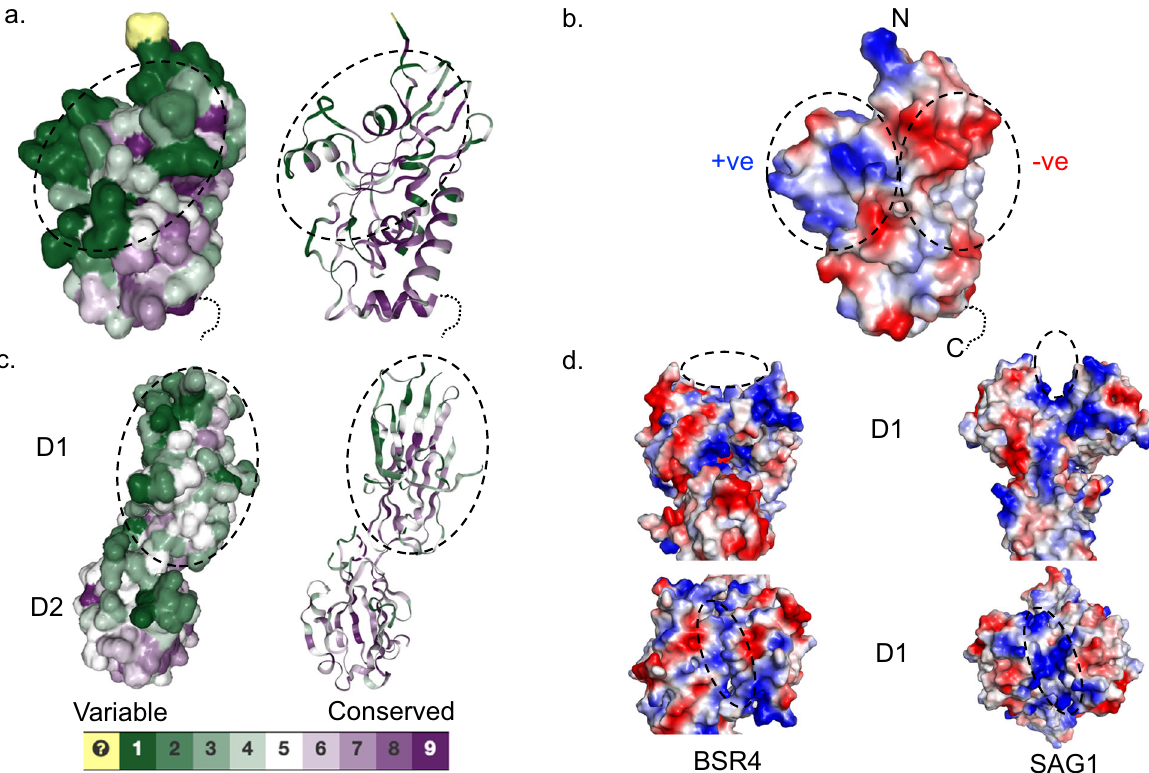
Fig. 4 Surface conservation and electrostatic distribution found within E. tenella and T. gondii SAGs. a Surface (left) and cartoon (right) representation of EtSAG19 displayed using the Consurf sequence conservation colour scheme with purple indicating the most strongly conserved. This indicates that the maximal sequence variability lies on the surface of the molecule distal from the C-terminal GPI anchor. The associated cartoon diagram indicates that the conservation is located within the buried core of the protein. b Electrostatic representation of the surface of EtSAG19. This highlights the distinct localisation of charge to the N-terminal end of the molecule as part of which one face has a local net negative charge whilst the other is positive. c Surface (left) and cartoon (right) representation of T. gondii BSR4 monomer displayed using the Consurf sequence conservation colour scheme. This highlights the high degree of sequence variability found within the interconnecting loops of the D1 domain, distal from the C-terminal anchor, whereas the D2 domain is highly conserved. d Electrostatic representation of the T. gondii D1 domains from the BSR4 (left) and SAG1 (right) dimers. In the top view the twofold of the dimer is vertical, whereas in the lower view it is towards the reader. This shows that the maintenance of a charged cluster of residues at the dimer interface of both SAGs, which form a cleft, believed to be important for molecular interaction of their respective targets. Electrostatic ranges of kbT/e – represented by dark red to dark blue that are set by the programme defaults are as follows: EtSAG19 ( – 67.9 to 67.9), SAG1 ( – 63.6 to 63.6) and BSR4 ( – 61.5 to